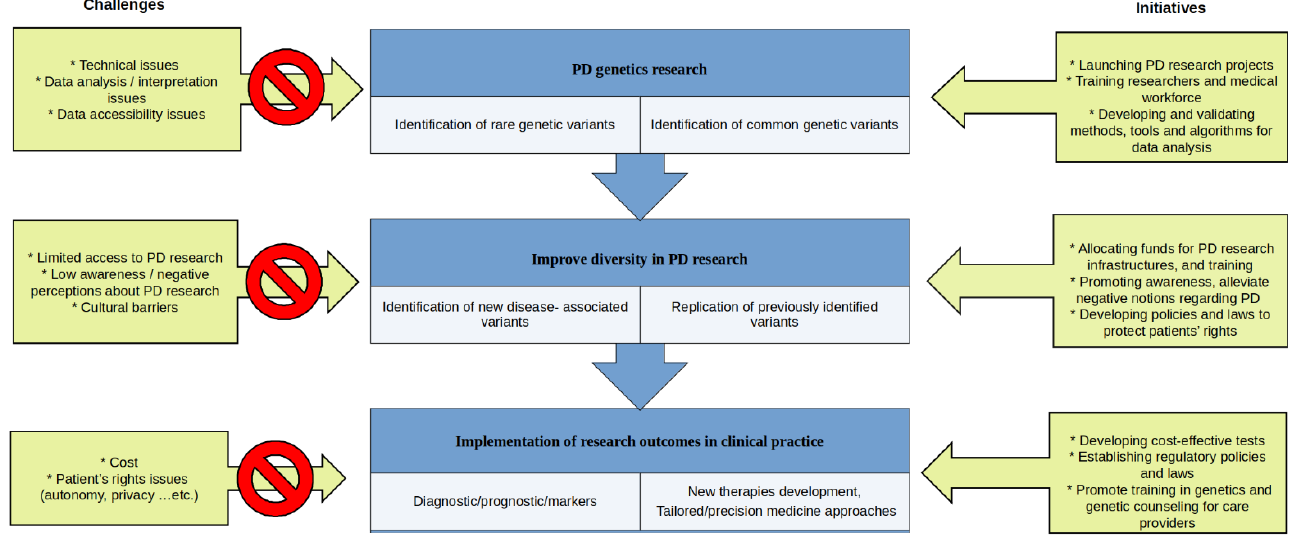
Figure 1. The Parkinson’s disease genetics path: From research to clinics. Parkinson’s disease (PD).